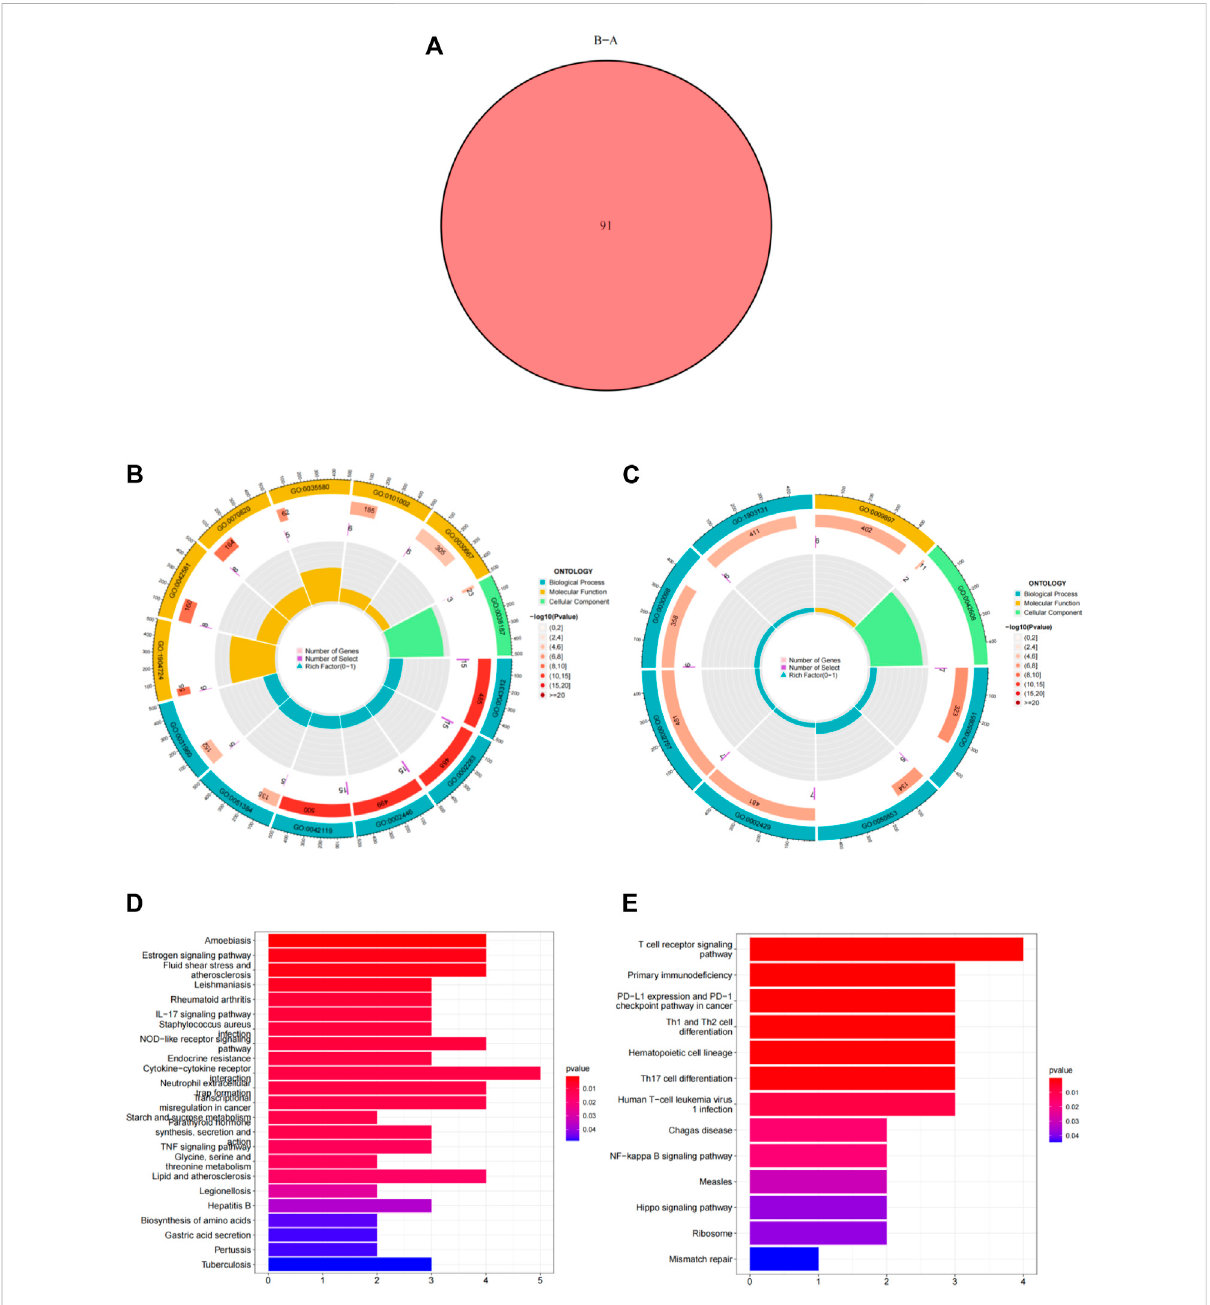
FIGURE 6 Differentially expressed genes (DEGs) and enrichment analysis between cluster A and cluster B. (A) Venn diagram representing the intersection of DEGs between cluster A and cluster B. (B) Gene ontology analysis of upregulated DEGs in cluster A. (C) Gene ontology analysis of